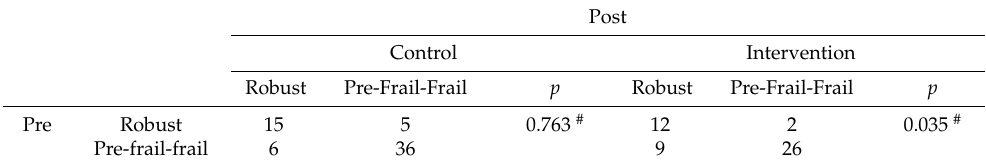
Table 4. Comparison of the number of participants who were robust and pre-frail-frail pre-and